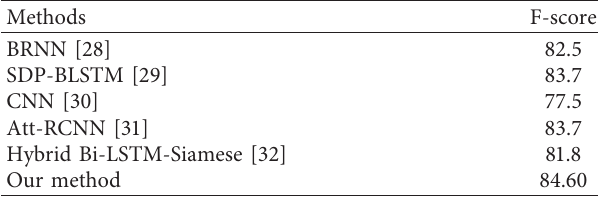
Table 2: Chinese entity relationship extraction precision.